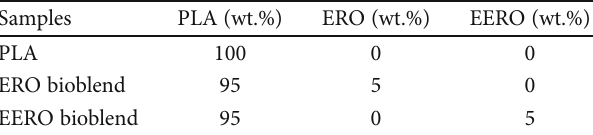
Table 2: The names of bioblend and its composition. Samples PLA (wt.%)